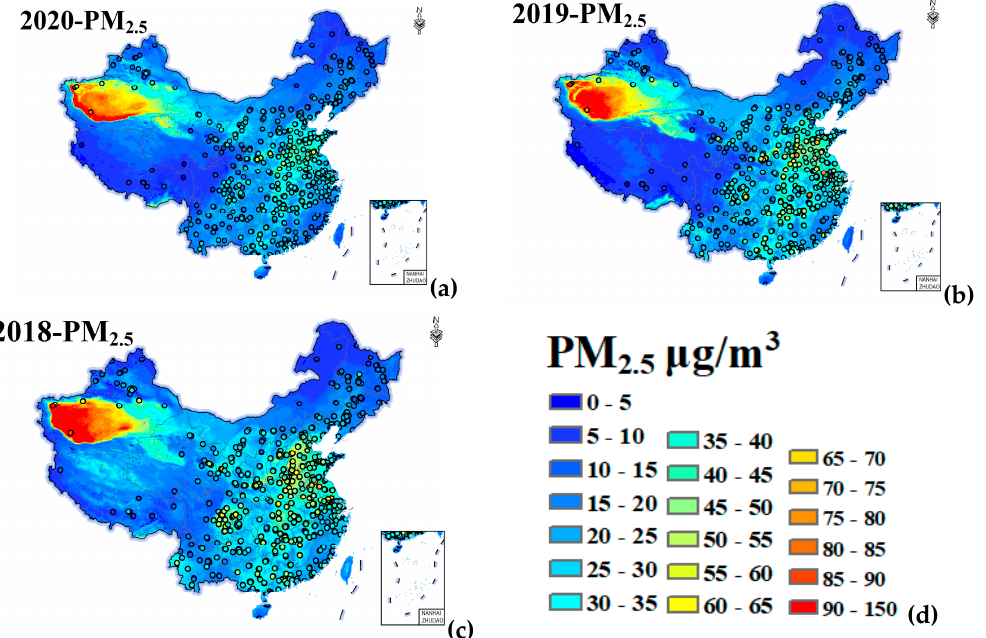
Figure 8. Annual average distribution of PM 2.5 concentration. (a) , (b) , and (c) represent 2020, 2019, and 2018, respectively. (d) is a legend.